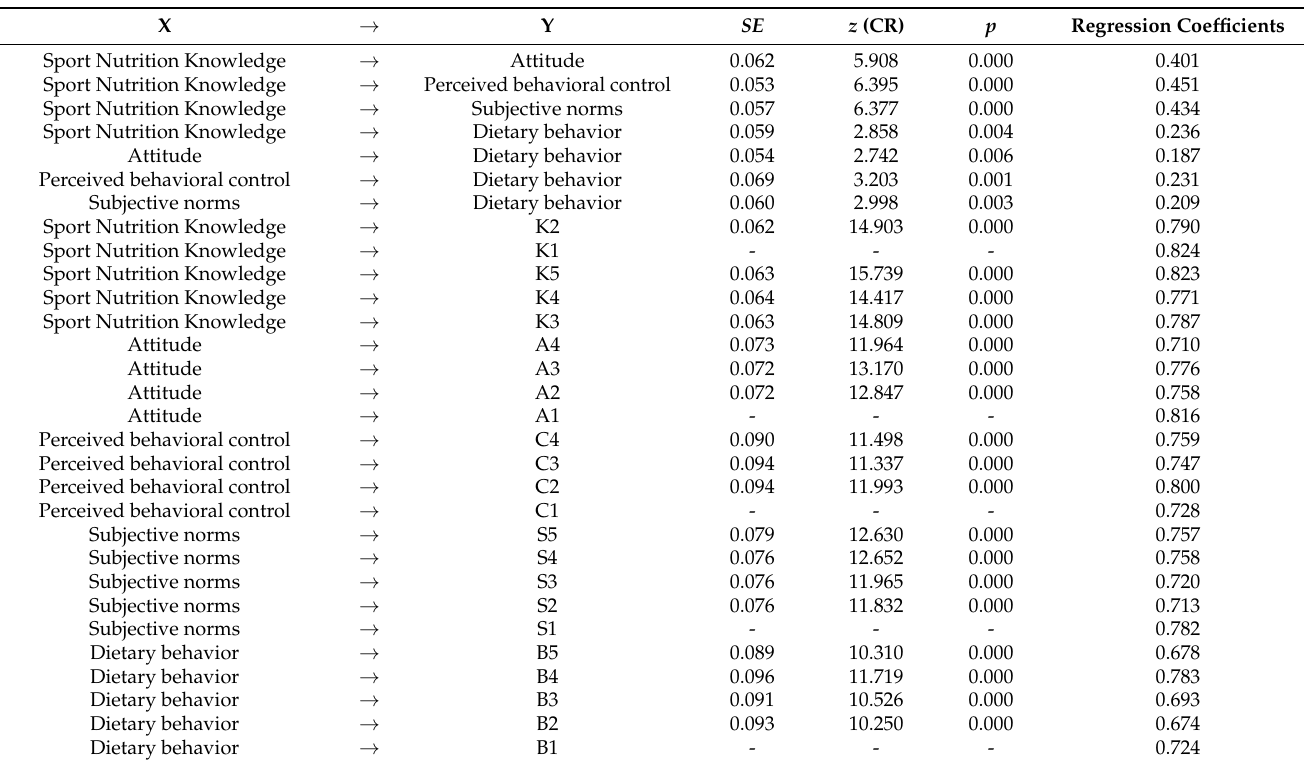
Table 6. Model regression